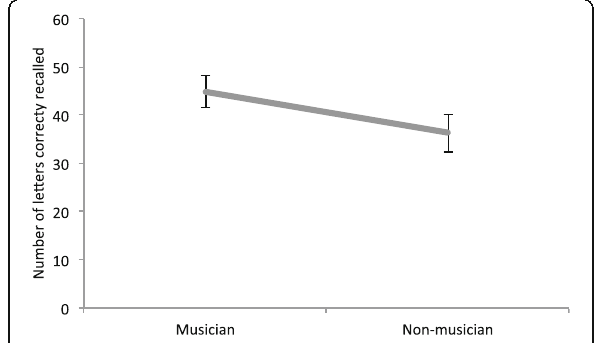
Fig. 3 Musician status in the operation span task. Musicians recalled more letters, that is, had a larger working memory span than non- musicians. Error bars represent